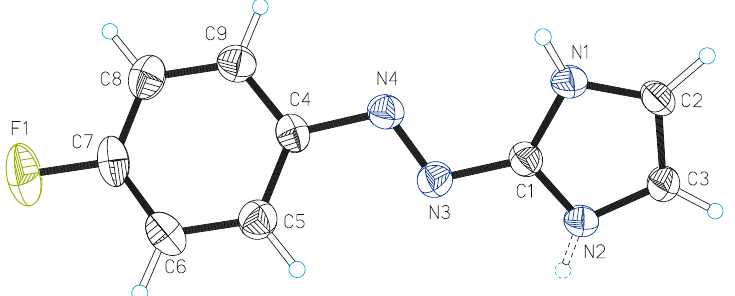
Figure 1. Molecular structure with non-H atoms depicted as ellipsoids at the 50% probability level and H atoms drawn as spheres of random size. The location of the NH group is either at N1 or N2 (1:1 disorder).